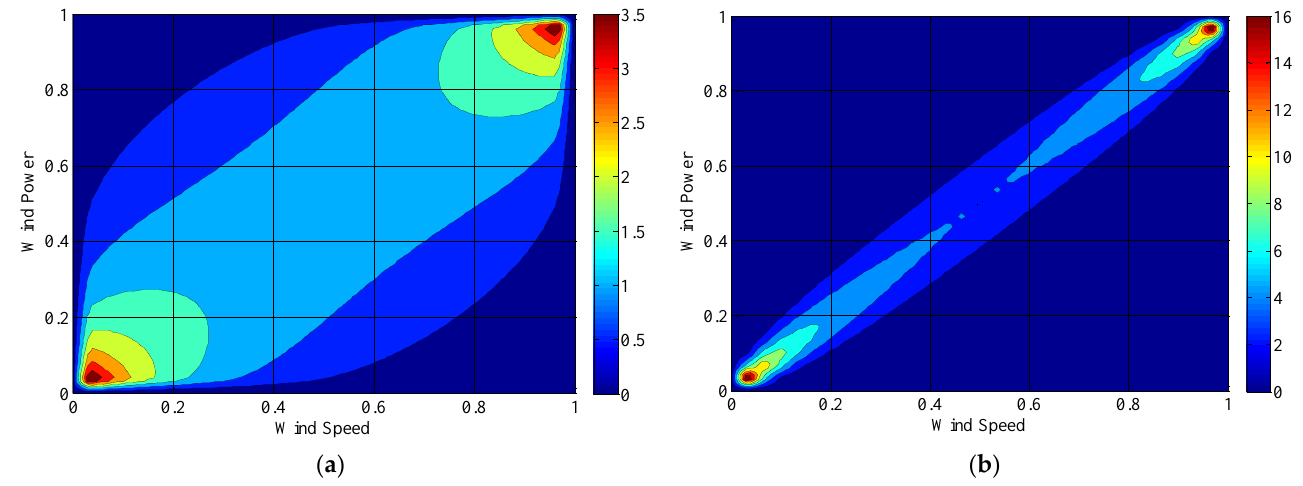
Figure 4. Distribution density map of wind speed and power: ( a ) distribution density map of wind speed; ( b ) distribution density map of wind power.